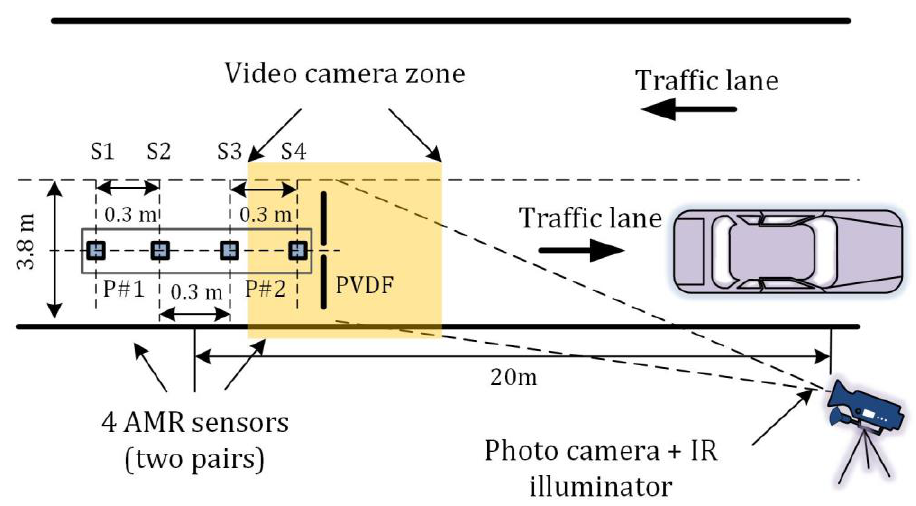
Figure 1. Vehicles speed measurements system prototype. It is equipped with four anisotropic magneto-resistive (AMR) magnetic sensors, a traffic surveillance camera, and polyvinylidene fluoride (PVDF) sensors for estimating ground-truth speed [8].